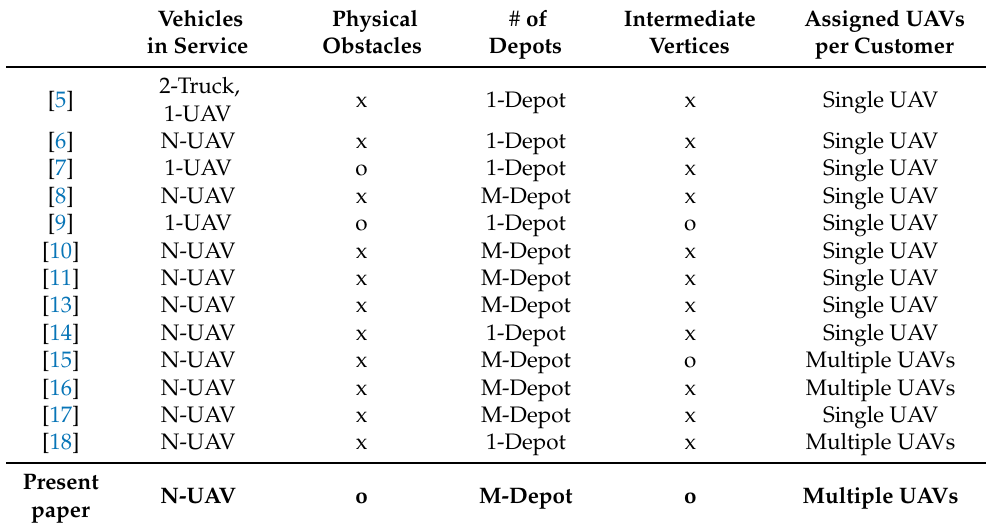
Table 1. The research related to the unmanned aerial vehicle (UAV) routing